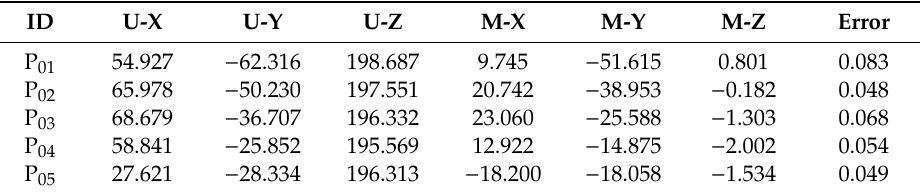
Table 2. Three-dimensional coordinates of five ground object points with the same name in the UAV and mixed data (U represents UAV data, M represents mixed data, the unit is